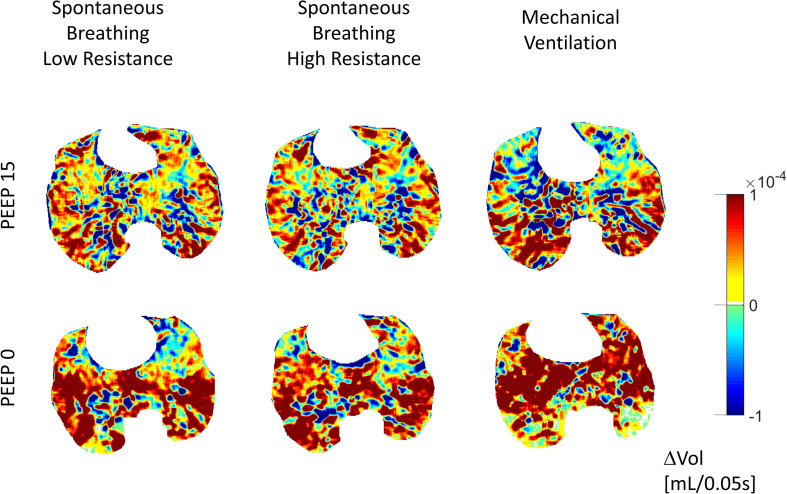
Gas redistribution during ongoing inspiratory flow: delta-volume images (ΔVOL). Large and few areas of gas redistribution (gas displacing) characterized low PEEP, high external resistances (SB-HighR), and controlled mechanical ventilation. Small and diffused areas of gas redistribution (gas displacing) characterized high PEEP, low external resistances (SB-LowR), and spontaneous breathing. Color scale: inflating areas in yellow–orange–red and deflating areas in green–sky–blue.